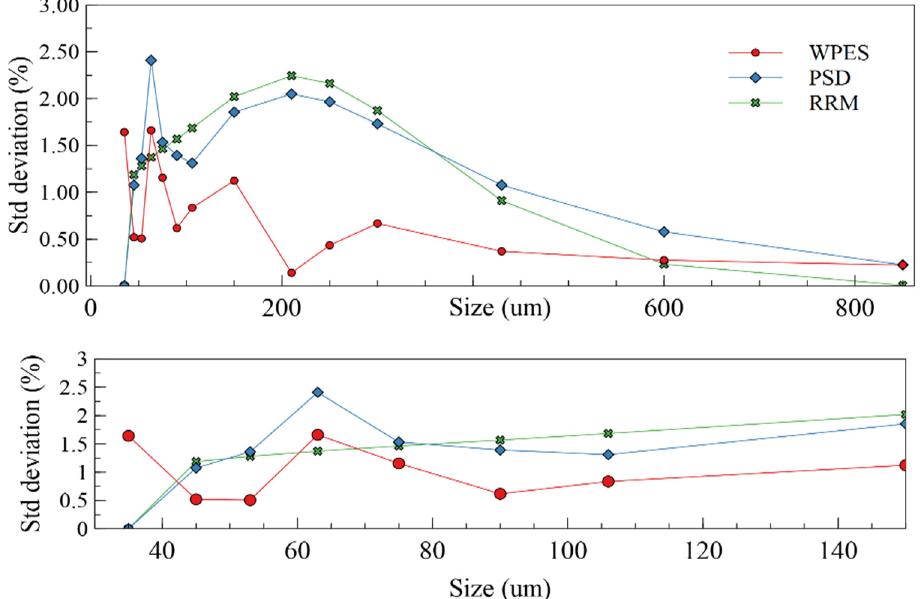
Figure A2. Standard deviation for grinding time of 12 min with 95% confidence. ( Top ) WPES, PSD, and RRM for all range size; ( Bottom ) those for mainly fine sizes.